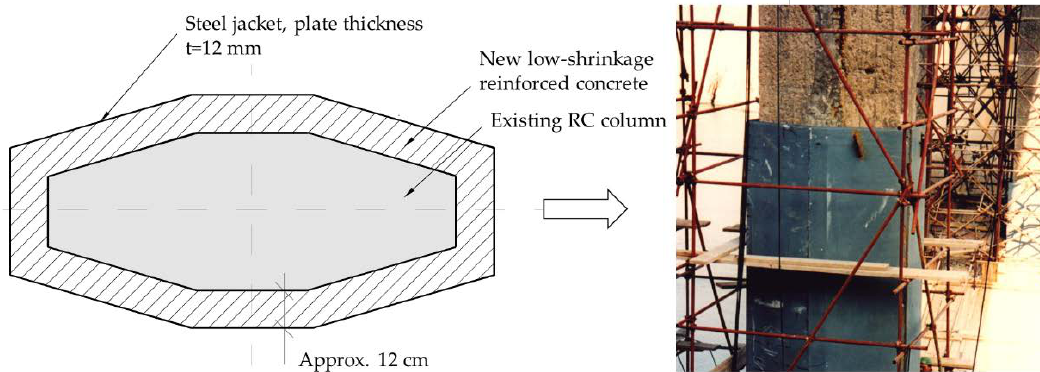
Figure 2. An example of reinforced concrete jacketing of existing columns.